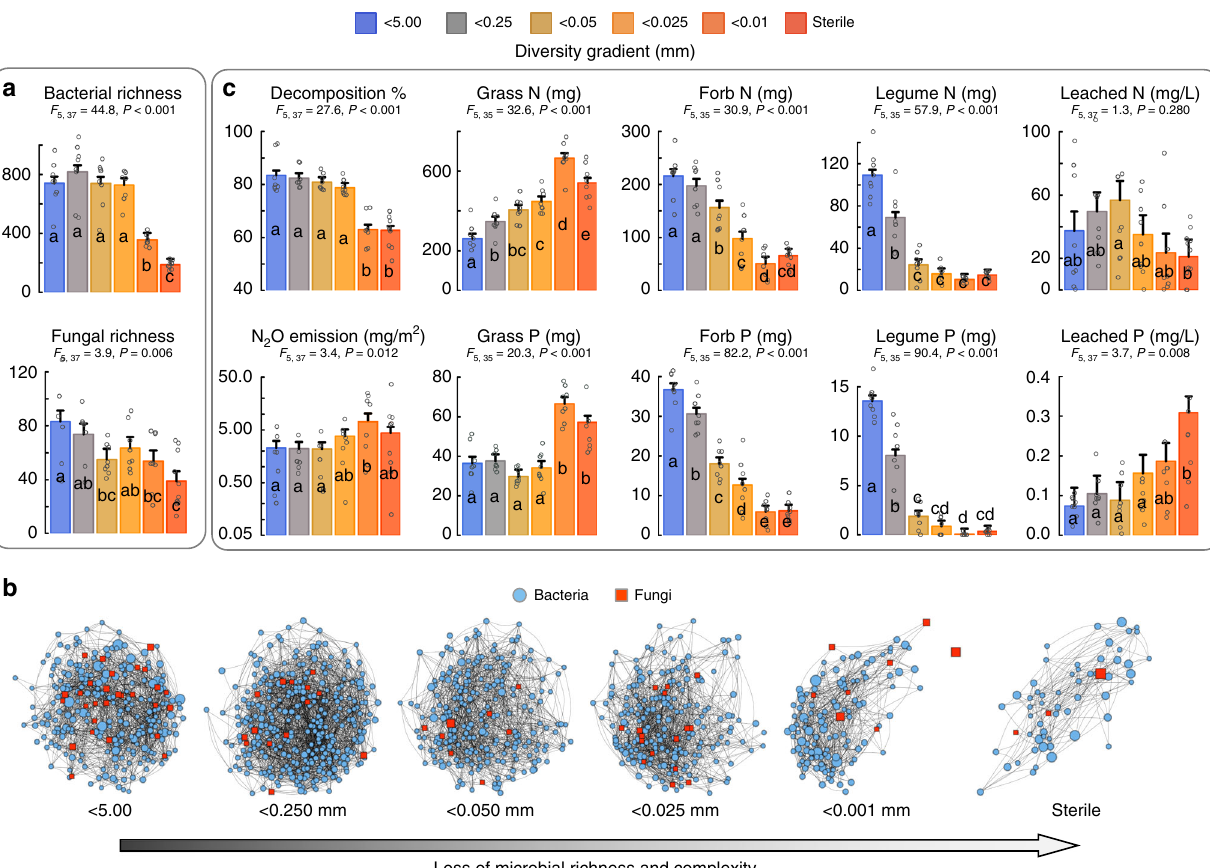
Fig. 1 Soil microbial community composition and ecosystem functioning with progressive simpli fi cation of the soil biome. The soil diversity gradient was established by fi ltering inoculum through different meshes: ≤ 5; ≤ 0.25; ≤ 0.05, ≤ 0.025, ≤ 0.001 mm, or adding sterilized soil inoculum. Shown are ( a ) the mean richness of bacterial and fungal OTUs and ( b ) the microbial association networks where blue circles indicate individual bacterial operational taxonomic units (OTUs), red square nodes indicate individual fungal OTUs and lines indicate interlinkage between OTUs. For visual clarity, only OTUs that were detected to be present in 75% of all replicates within each treatment level are illustrated. Networks are based on subsets of a meta-network matrix where subset matrices were generated using only OTUs present within a treatment. Connectedness within the meta-network was 2.2% (70,830 links out of 3,290,596 possible links). Larger nodes indicate the OTU was relatively more abundant within that particular treatment. c The mean of ecosystem functions related to nutrient cycling for each of the soil community treatments. Error bars in a and c are standard errors and different letters indicate signi fi cant differences (Tukey HSD) between treatments ( n = 8 for each treatment level with n = 10 for the sterile treatment, except for plant nutrients where n =